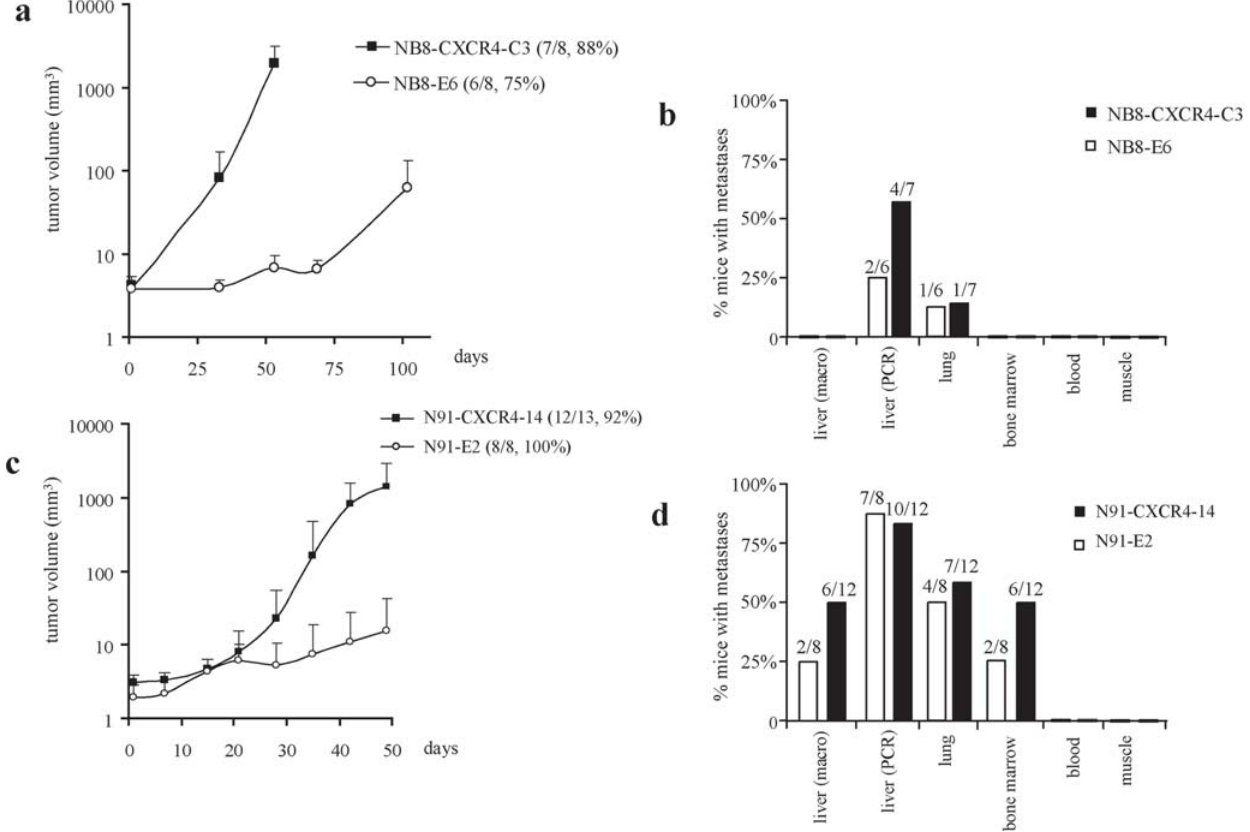
Figure 2. Invivoorthotopic tumour growth and metastasis. Tumour growth measured in mice engrafted with NB8-E6 and NB8-CXCR4-C3 (a), and N91-E2 and N91-CXCR4-14 (c) The mean tumour volume 6 S.D. as measured by echo-doppler at indicated days after implantation is shown. The tumour take expressed as number of mice with tumour/total mice and percent mice with tumours is indicated. (b) and (d) Detection of metastases in mice engrafted with either NB8-E6/NB8-CXCR4-C3 or N91-E2/N91-CXCR4-14 cells. Macroscopic liver metastases were detected by gross examination. Micrometastases were detected in lung, bone marrow, muscle and blood by GFP-PCR. Bars represent percentages of mice with macroscopic liver metastases or GFP-PCR positive signals in indicated organs per tumour bearing animal.